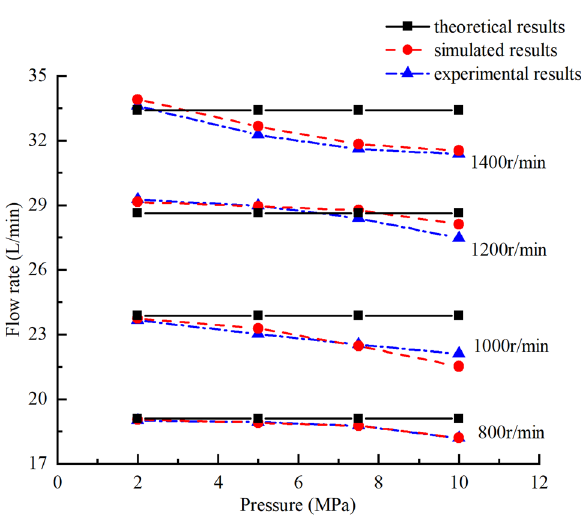
Figure 32. Comparisons of theoretical, numerically and experimentally obtained pressure–flow (p–Q)